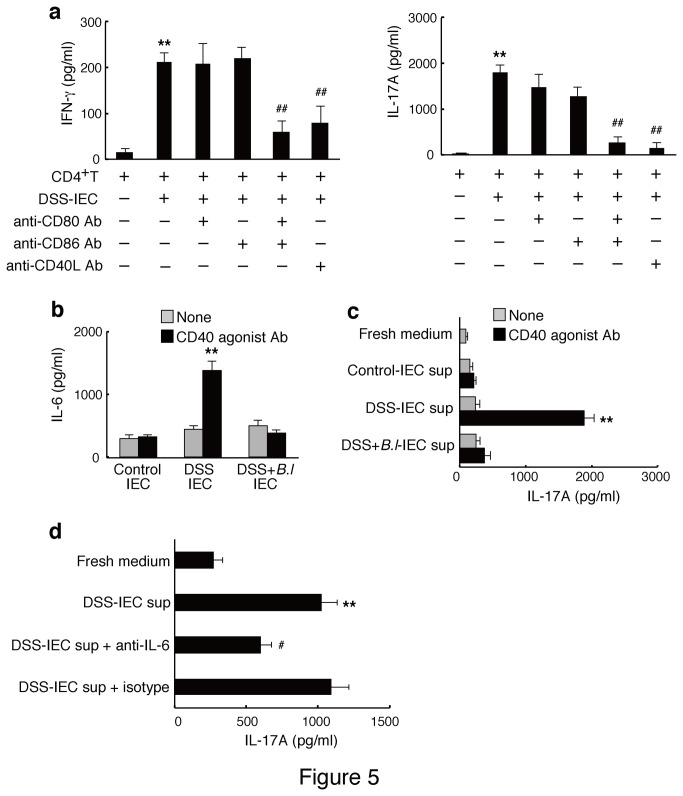
IECs from DSS mice induce IL-17A response via CD80/CD86 and CD40 dependent costimulation.(a) IECs from DSS mice were co-cultured with CD4+ T cells from control mice in the presence of anti-CD3 antibody. In the indicated groups, IECs were pretreated with CD80 or CD86 blocking antibodies, and CD4+ T cells were pretreated with CD40L blocking antibody before co-culturing. The data are representative of two experiments. Results are expressed as means ± standard error (n = 4). **
p<0.01 versus CD4+ T cells alone (CD4+T); ##
p<0.01 versus co-culture of CD4+ T cells and IECs from DSS-treated mice (DSS-IEC). (b) IECs were cultured in the absence (gray bars) and presence (black bars) of CD40 agonist antibody for 24 h. IL-6 concentration in the supernatant was measured by ELISA. The data are representative of three experiments. (c) CD4+ T cells were cultured for 3 days in fresh medium or supernatant from IECs (IECs sup) cultured as described in (b) in the presence of anti-CD3/CD28 antibodies. The IL-17A concentration in the supernatant was measured by ELISA. The data are representative of two experiments. Results are expressed as means ± standard error (n = 4). **
p<0.01 versus the supernatant from IECs stimulated with CD40 agonist antibody (CD40 agonist Ab). (d) CD4+ T cells were cultured with fresh medium or supernatant from CD40-stumulated IEC of DSS mice (DSS-IEC sup) as described in (c) in the presence of IL-6-neutralizing antibody (anti-IL-6) or IgG control antibody (isotype). The IL-17A concentration in the supernatant was measured by ELISA. Results are expressed as means ± standard error (n = 6). **
p<0.01 versus fresh medium; #
p<0.05 versus the supernatant from CD40-stumulated IEC of DSS mice (DSS-IEC sup).